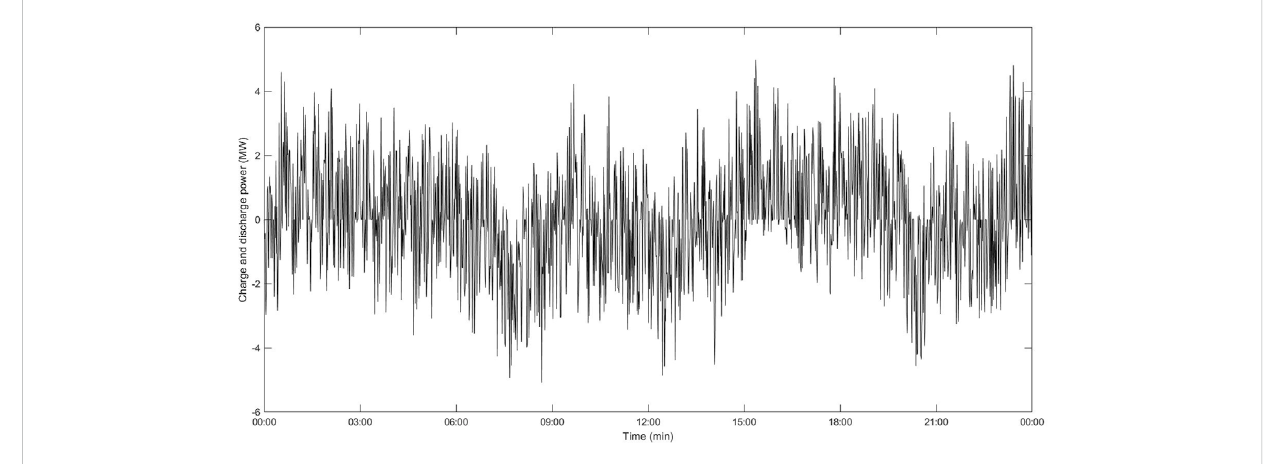
FIGURE 10 Charging and discharging power